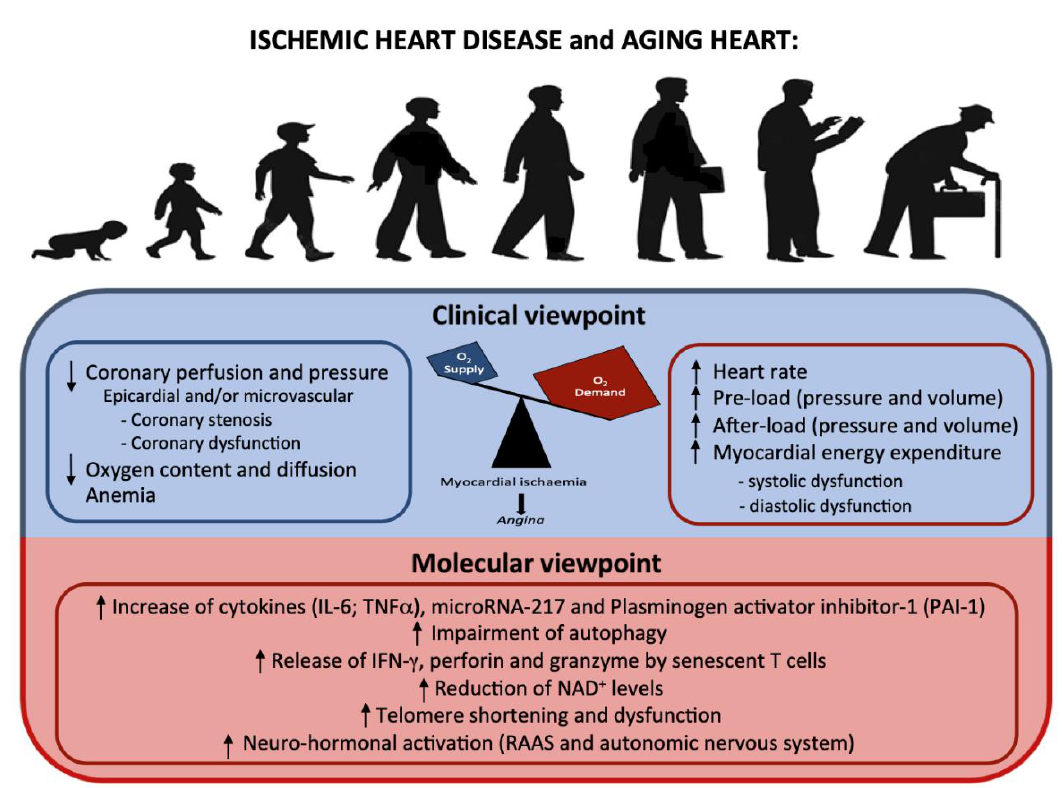
Figure 3. Aging heart and ischemic heart disease: from clinical to molecular viewpoint. An increase in O 2 demand in the context of a diminished O 2 supply leads to myocardial ischemia. The patho- physiological factors that cause these alterations are listed in the upper figure. In the lower figure, the molecular modifications secondary to the increased cellular stress are listed.